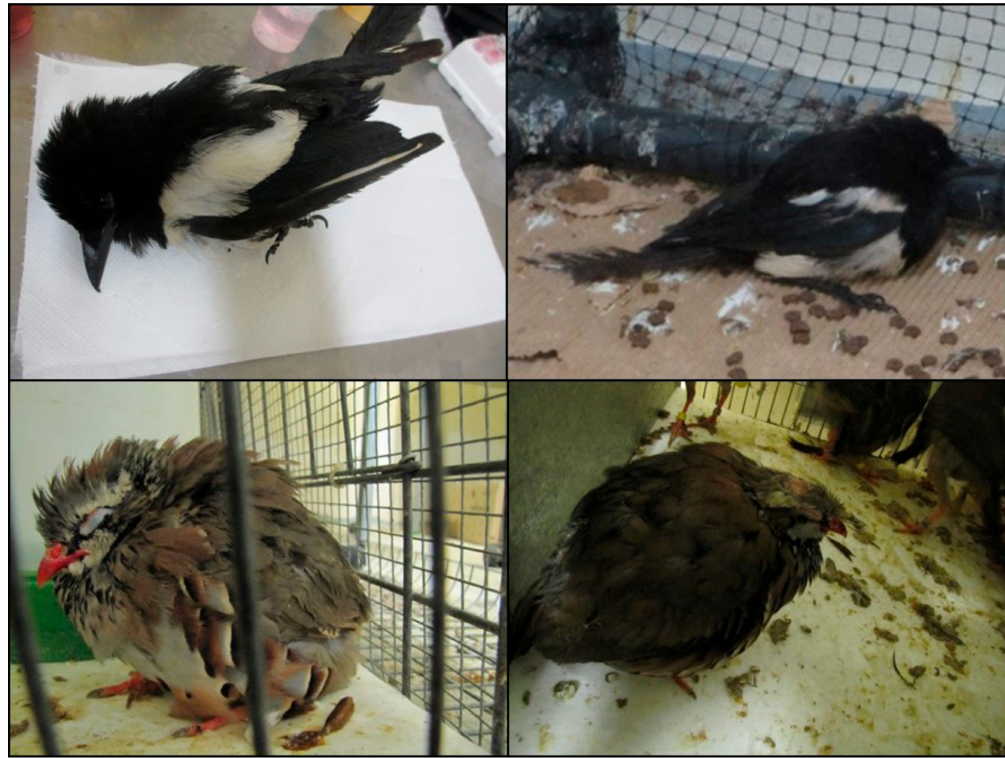
Figure4. Clinicalsignsobservedinexperimentallyinfected birds. Magpies(upperpanel)andpartridges (lower panel) experimentally infected with WNV. Birds that die develop high morbidity hours before their death. Evident clinical signs like loss of appetite, ru ffl ed feathers, paralysis, hunchback position, and unresponsiveness are observed in WNV-infected birds from 3 to 8 days post-infection